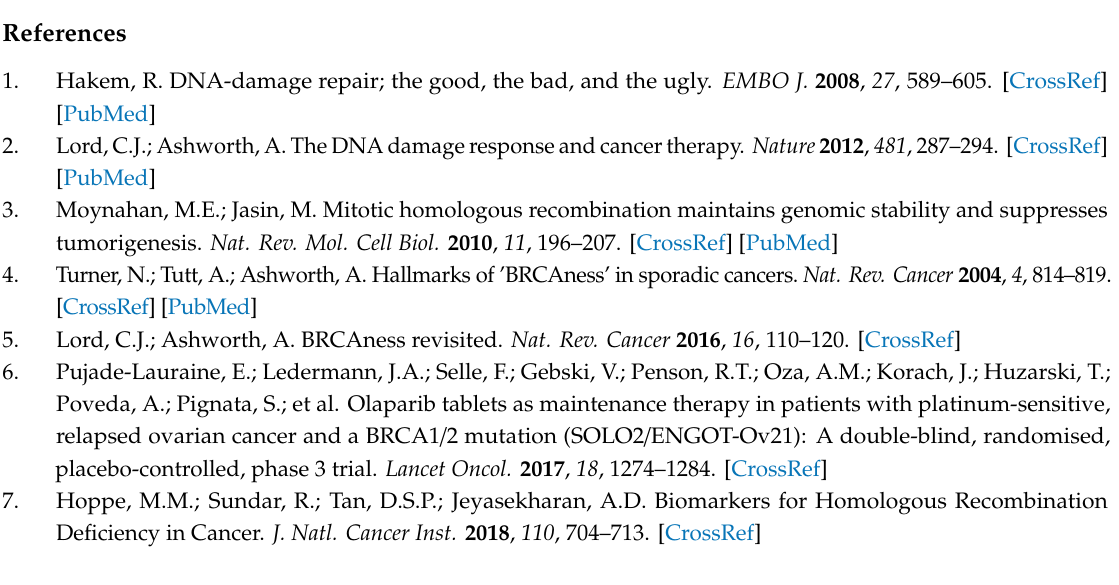
Figure S1: Tissue classes learned from Convolutional Neural Network (CNN) in breast